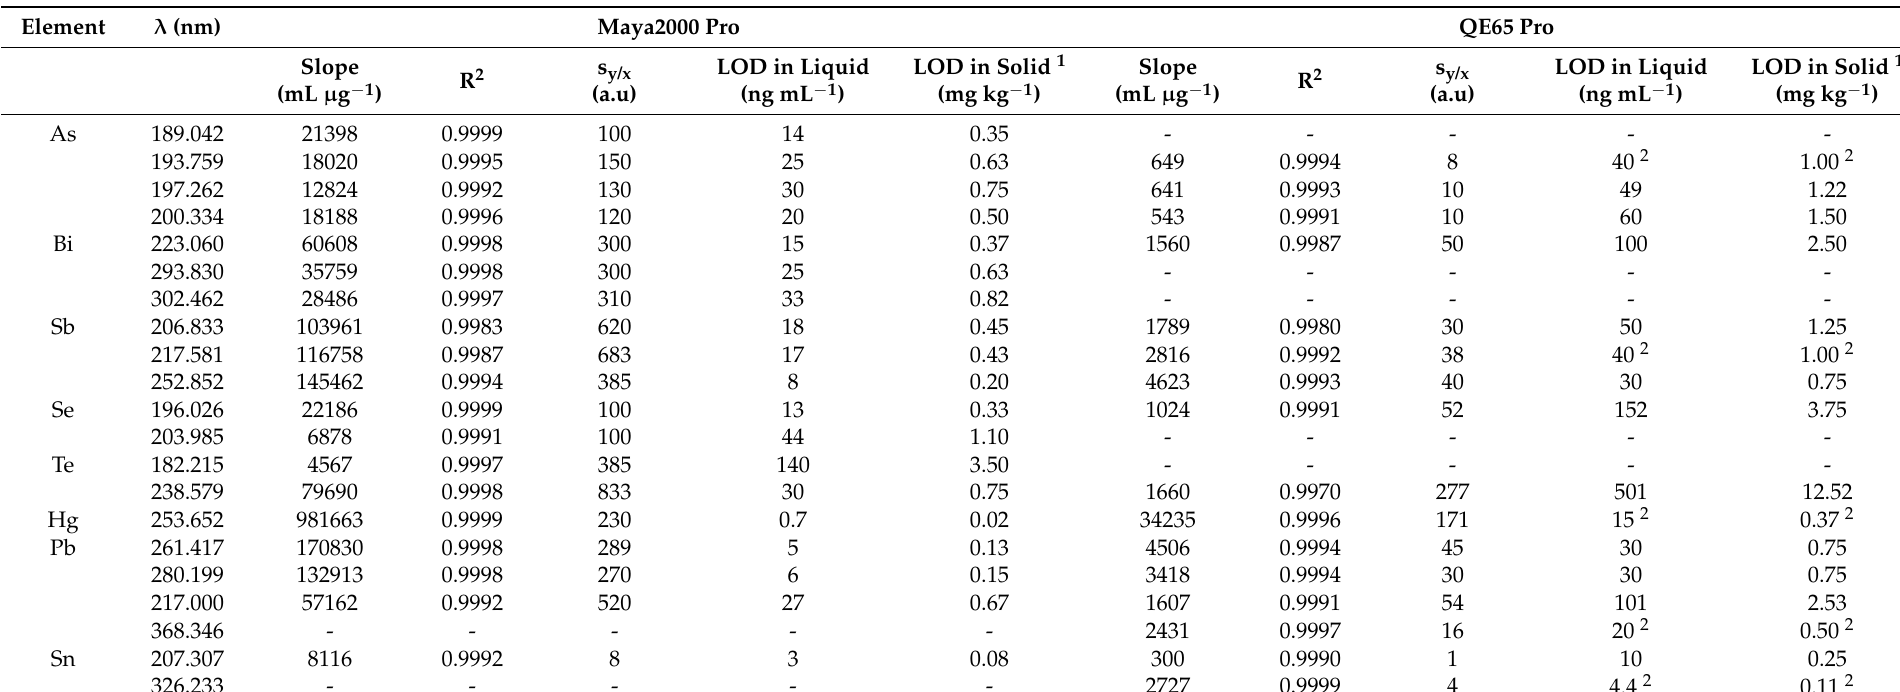
Table 2. Parameters of the calibration curves, LODs in liquid and solid samples by the SSETV- µ CCP-OES method using Maya2000 Pro and QE65 Pro microspectrometers for peak area measurement of the transient